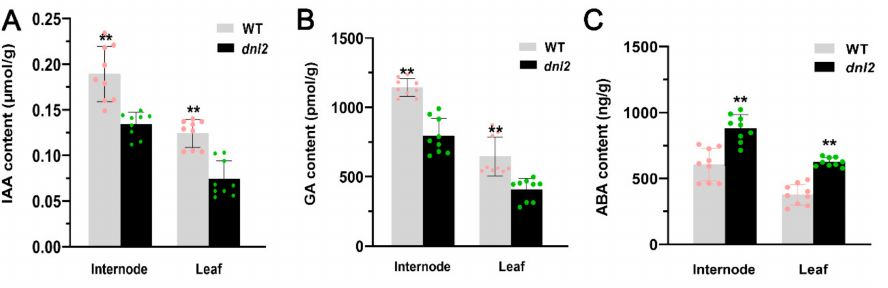
Figure 7. Measurement of endogenous hormones in dnl2 and the wild-type seventh internode and 15th leaf at the V15 stage. ( A ) Measurement of IAA content. ( B ) Measurement of GA content. ( C ) Measurement of ABA content. Asterisks indicate significant differences between dnl2 and the wild-type (** p <